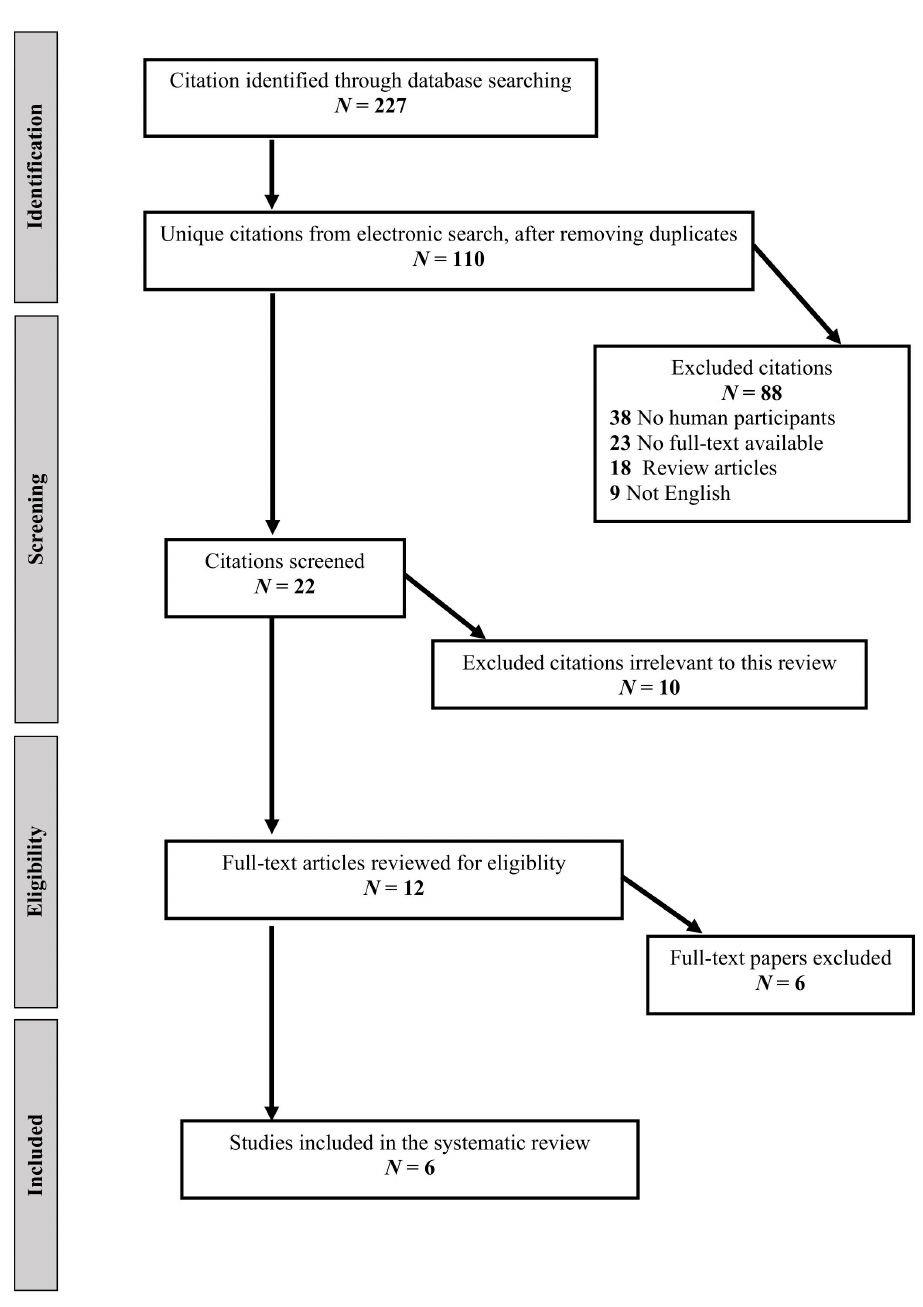
Figure 1. Systematic review flow